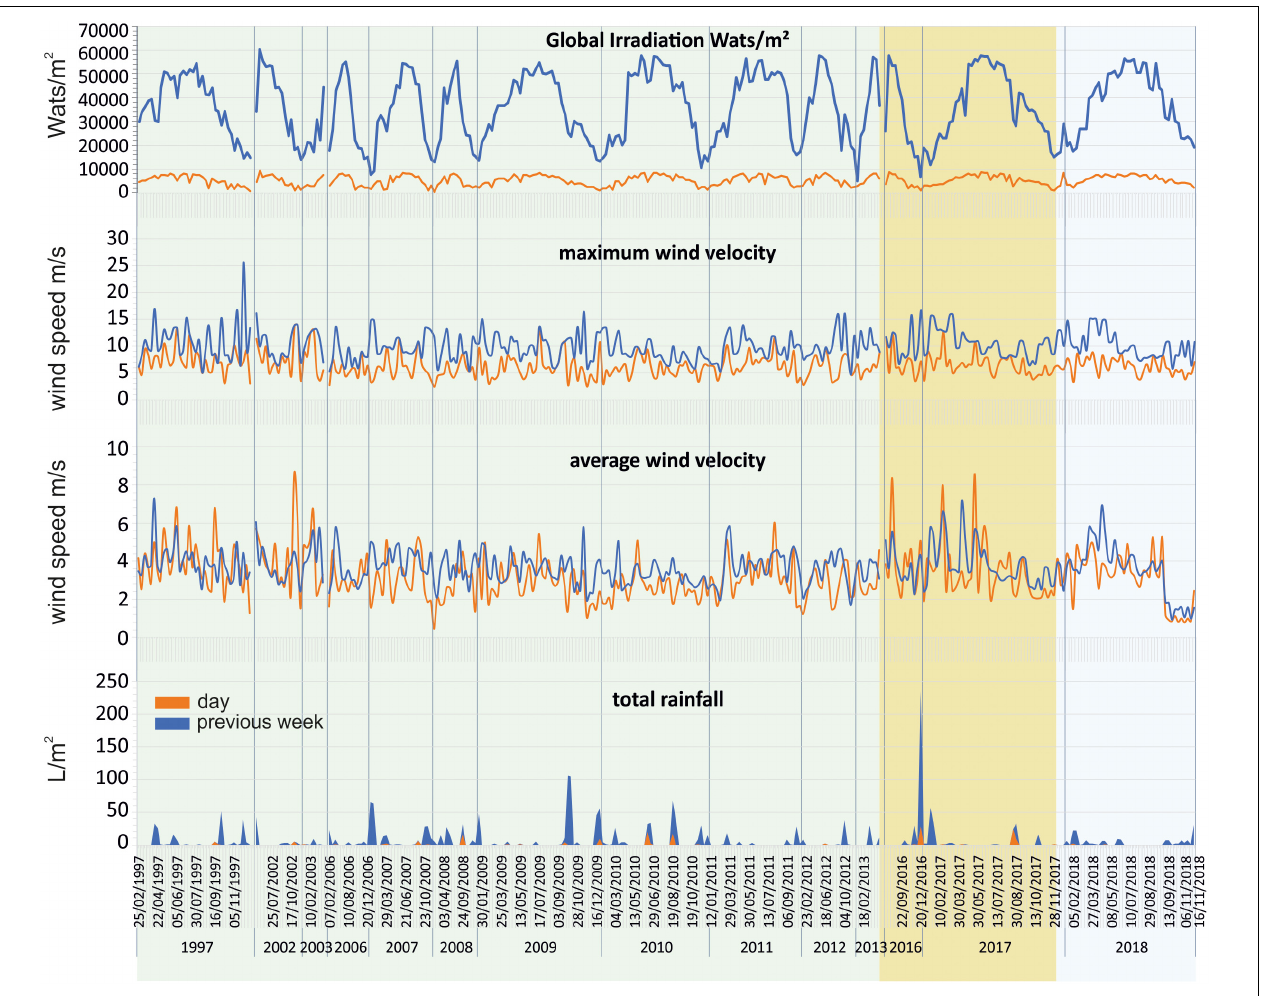
FIGURE 2 | Evolution of the main meteorological variables during the study period in the Mar Menor area. Prebreak phase is highlighted in green, Break phase in ochre, and Recovery in light